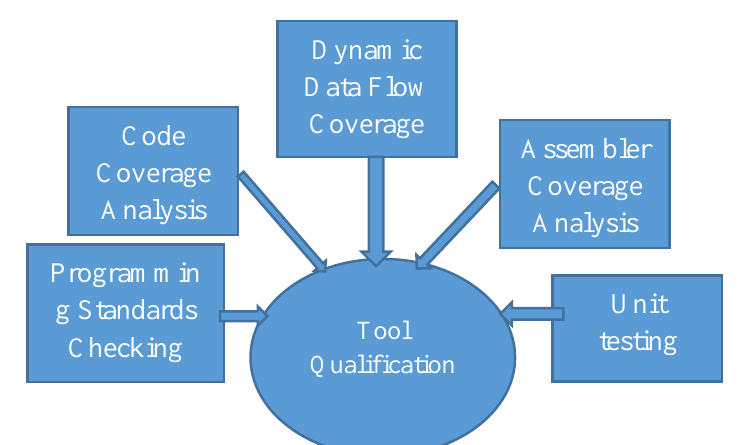
Fig. 6. Tool Qualification